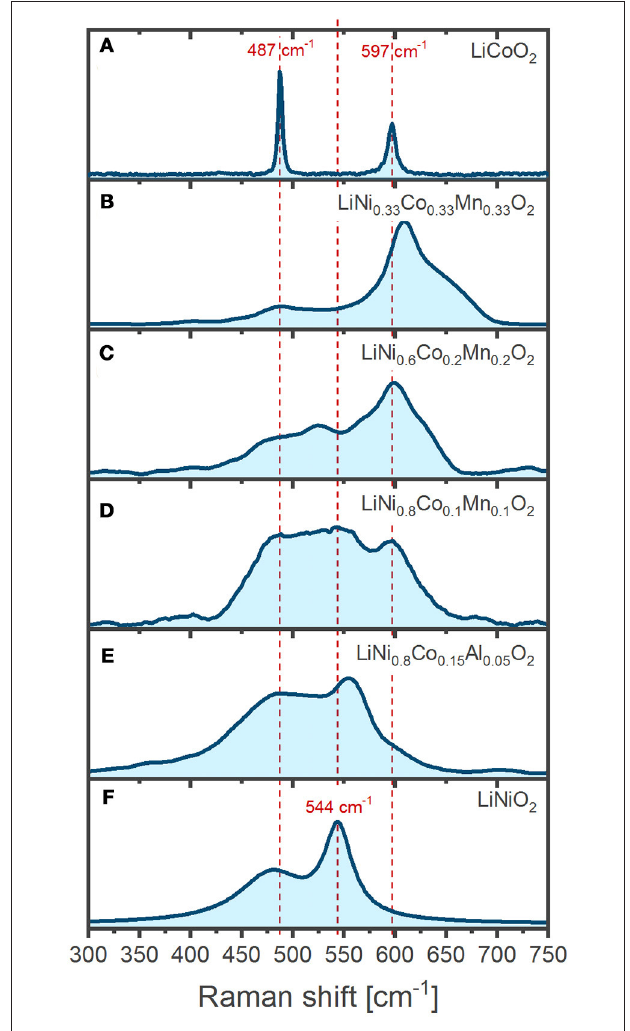
FIGURE 4 | Comparison of the Raman spectra from various isostructural LiMO 2 : (A) LiCoO 2 (LCO) (B) LiNi 0.33 Co 0.33 Mn 0.33 O 2 (NCM111) (C) LiNi 0.6 Co 0.2 Mn 0.2 O 2 (NCM622) (D) LiNi 0.8 Co 0.1 Mn 0.1 O 2 (NCM811) (E) LiNi 0.8 Co 0.15 Al 0.05 O 2 (NCA) (F) LiNiO 2